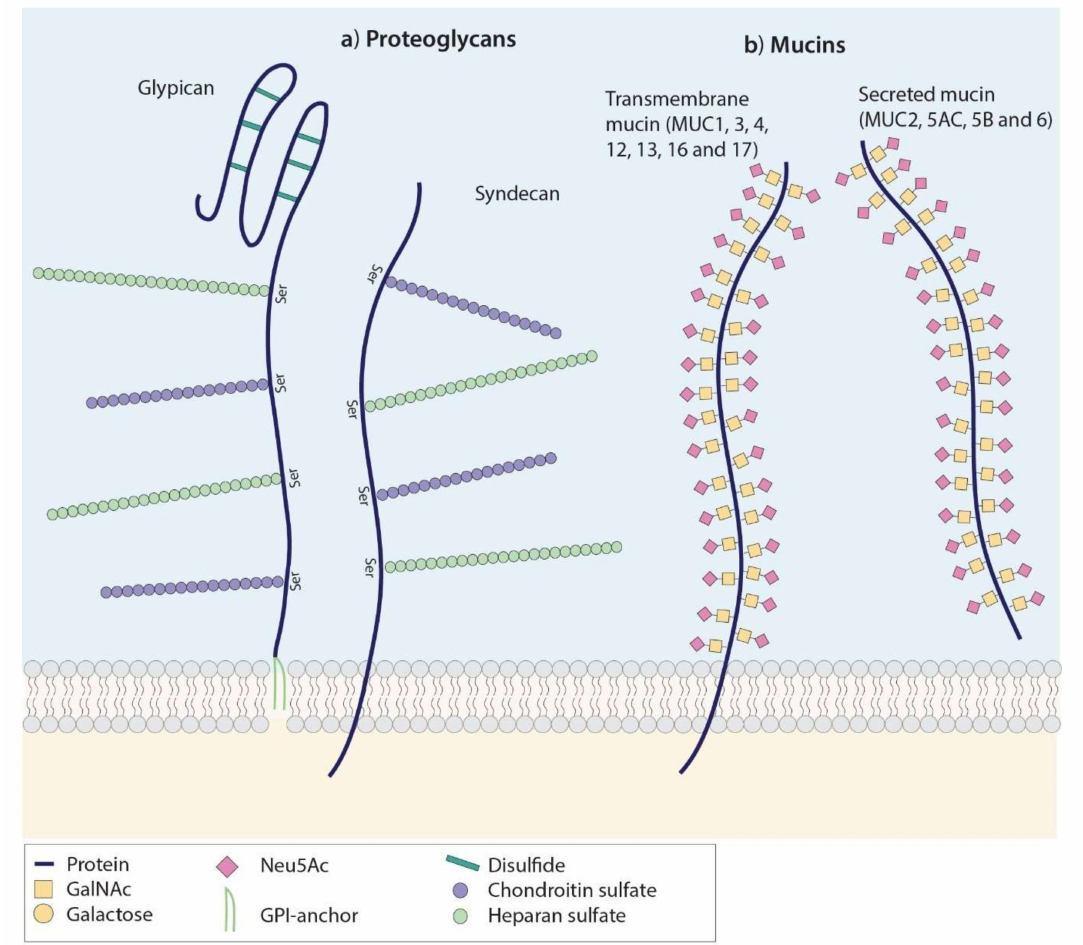
Figure 2. Schematic structure of heavily glycosylated glycoproteins. ( a ) Proteoglycans are transmembrane glycoproteinsthatconsistofacoreproteindecoratedwithglycosaminoglycan(GAG)chains. Inglypicans, the protein core is stabilized by disulphide bridges and linked to the cell membrane via GPI-anchors. Both glypicans and syndecans contain serine-linked heparin sulphate and chondroitin sulphate GAGs at both sides of the protein (here only depicted on one side), classifying them as HSPGs. ( b ) Mucins are high-molecular weight proteins that are extensively decorated with mucin-type O- Glycans, schematicallyillustratedherebythesTnepitope. Mucinsaresubdividedintotransmembrane (MUC1, MUC3, MUC4, MUC12, MUC13, MUC16, and MUC17) and secreted mucins (MUC2, MUC5AC, MUC5B, and